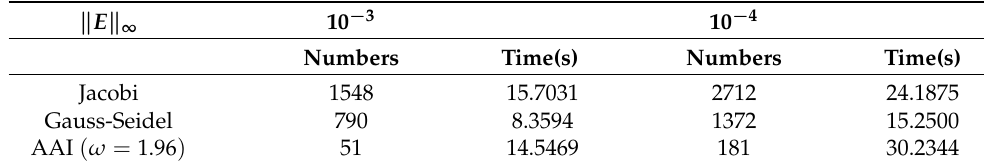
Table 7. The iteration numbers and time(s) of Jacobi, Gauss-Seidel and the AAI algorithm under the different error controls when l = m = s = 51, h = 1/50.